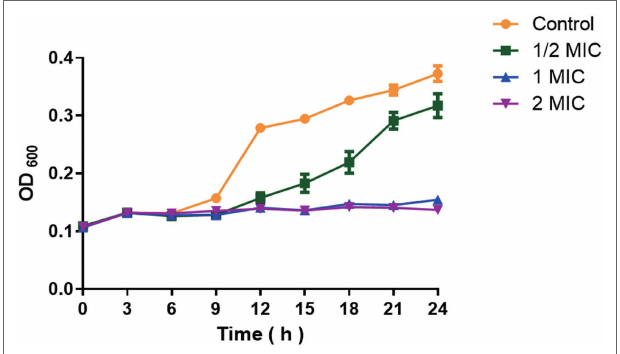
FIGURE 1 | Growth curve of moringin on Listeria monocytogenes